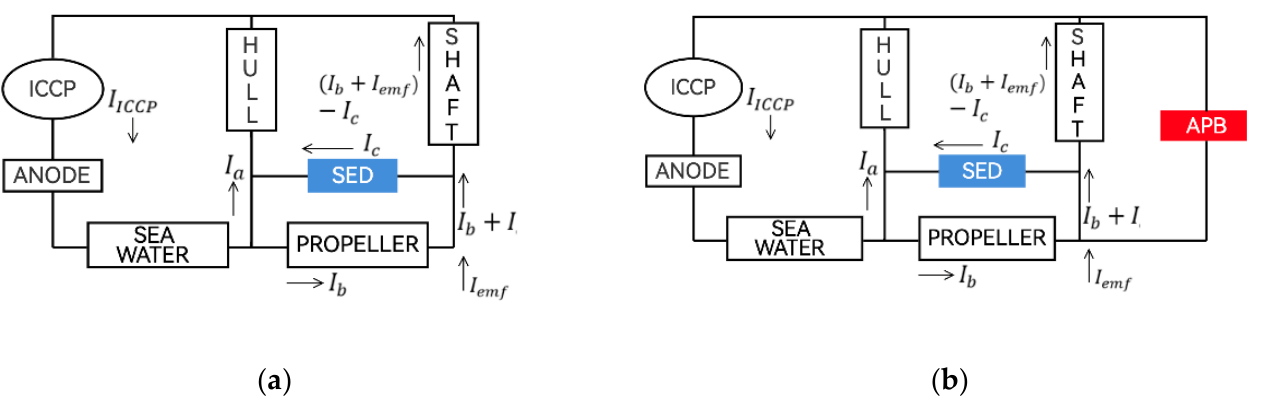
Figure 1. Circuit diagram of a marine electrical corrosion protection device: ( a ) passive shaft-grounding device and ( b ) electrical pitting prevention device with APB feedback adjustment system.